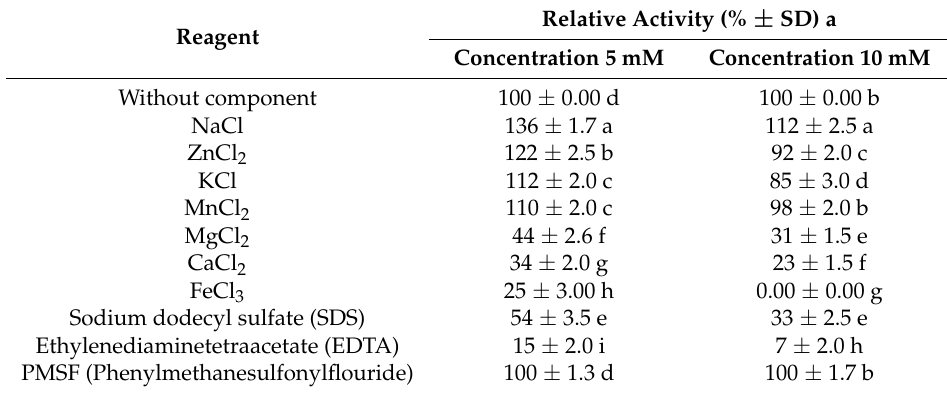
Table 3. Effect of metal ions on protease activity from P. candidum ( PCA 1/TT031).